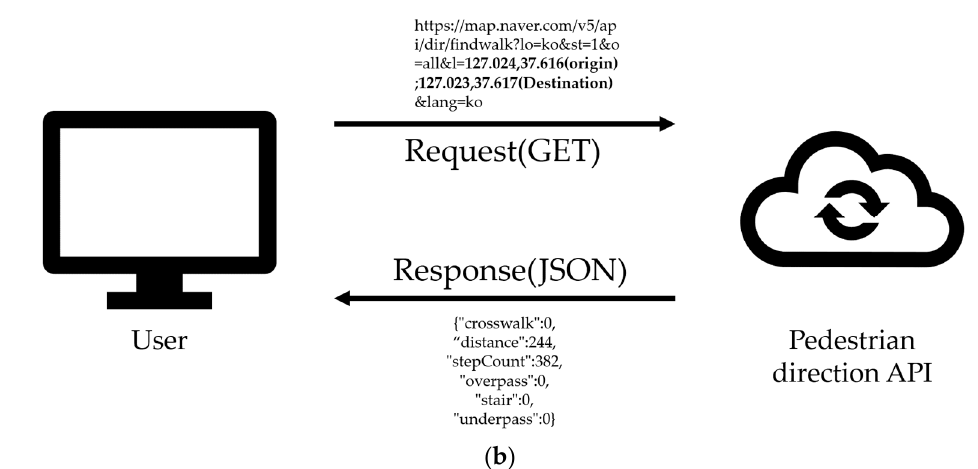
Figure 2. Pedestrian direction service of Naver map ( a ) Example of running a service in an application; and ( b ) process of obtaining walking information using the API.